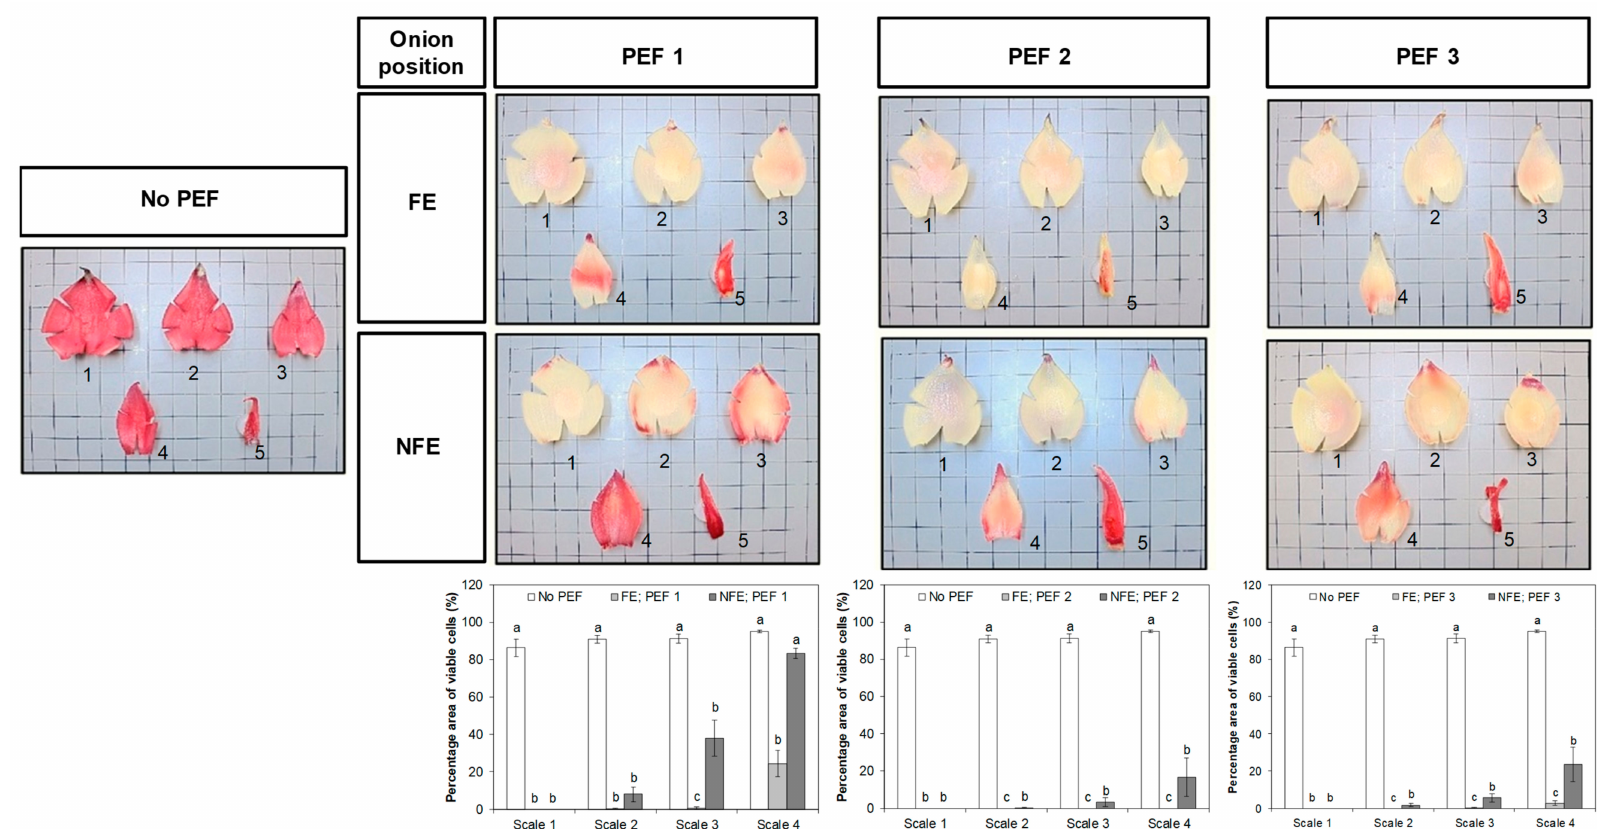
Figure 5. Representative photographs of onion scales from untreated (No PEF) and PEF-treated bulbs stained with tetrazolium salt and the percentage area fractions of viable cells (mean ± standard error, n = 3; bars with di ff erent lower-case letters indicate a significant di ff erence ( p < 0.05) between the onion orientations for each scale). Onion bulbs were positioned with either the root end facing the electrode (FE) or the root end not facing the electrodes (NFE) at the time of PEF application. Viable cells were stained red and dead cells were unstained. Number 1–5 indicates the fleshy scales and a terminal bud in an onion bulb, as designated in Figure